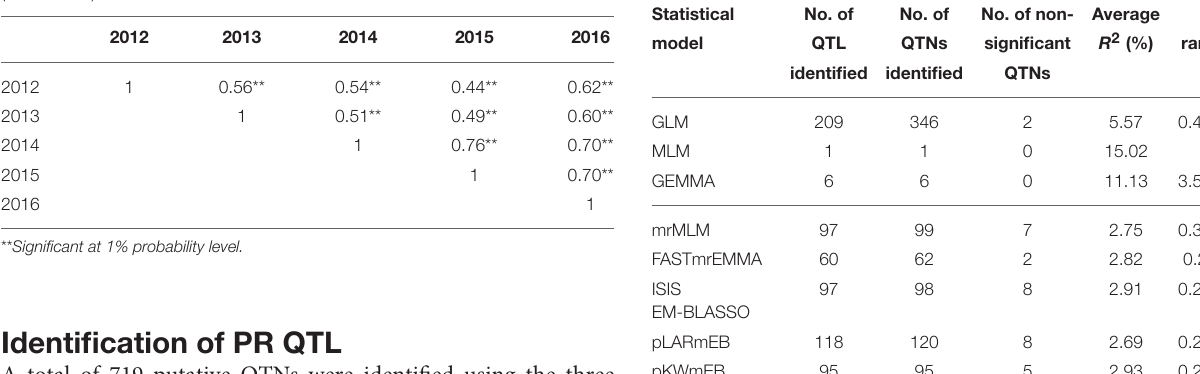
TABLE 3 | Spearman correlation coefficients of pasmo severity between years (2012–2016).